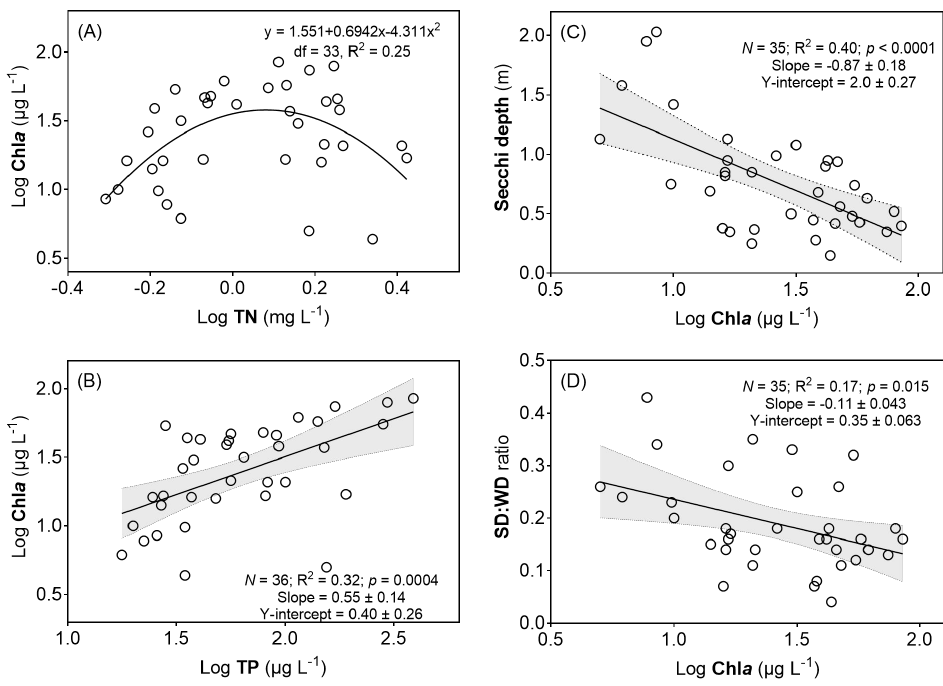
Figure 2. Relationships between ( A ) total nitrogen (TN) and ( B ) total phosphorus (TP) in the water, ( C ) water transparency (Secchi depth, SD), and ( D ) the ratio of Secchi depth to water depth (SD:WD) versus the concentration of Chl a . N , number of lakes; Chl a , chlorophyll- a concentration in phytoplankton. The dashed lines represent the 95% confidence band. Table 2. Results of the multiple regressions using a generalized linear model (GLM) to select the significant explanatory environmental variables for fish compositional data. Environmental variables: chlorophyll a concentration in